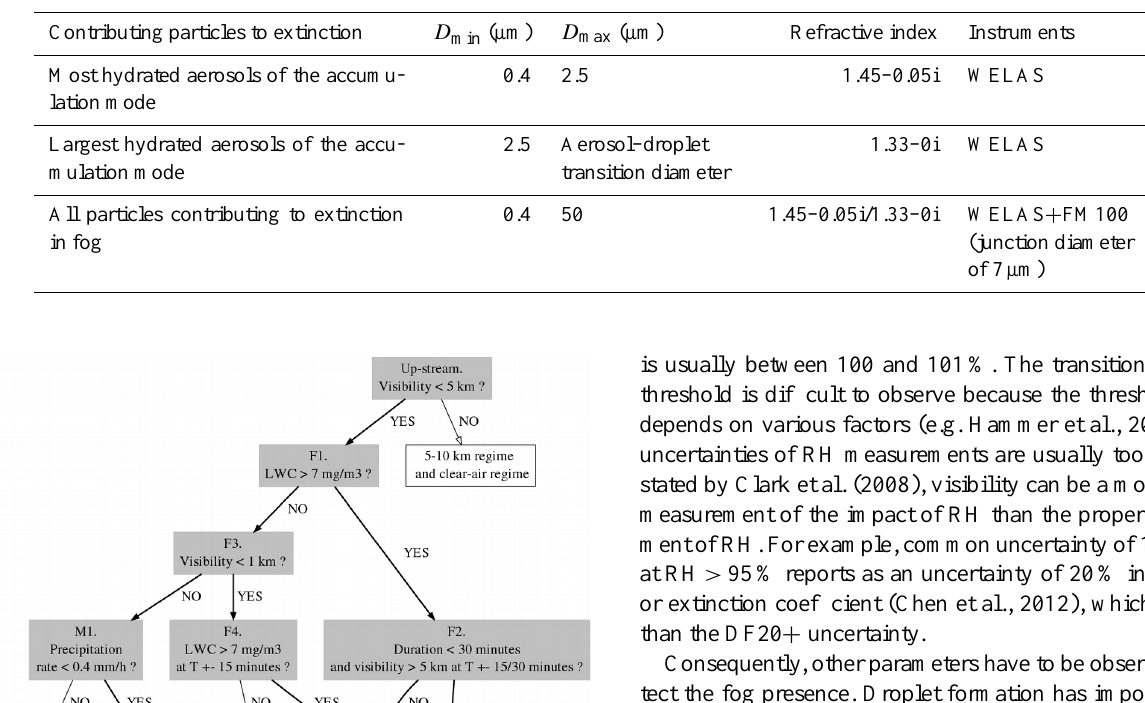
Table 2. Parameters of the Mie computations (Eq. 2) according to different particle populations. No value is given to the aerosol–droplet transition diameter as it is highly variable from one size distribution to another. Mean value was 4.0 ± 1.1µm.